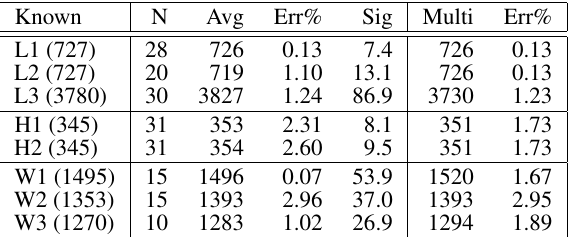
Table 2. Comparison of monoscopic (average) and multiscopic VW Thing measurements.